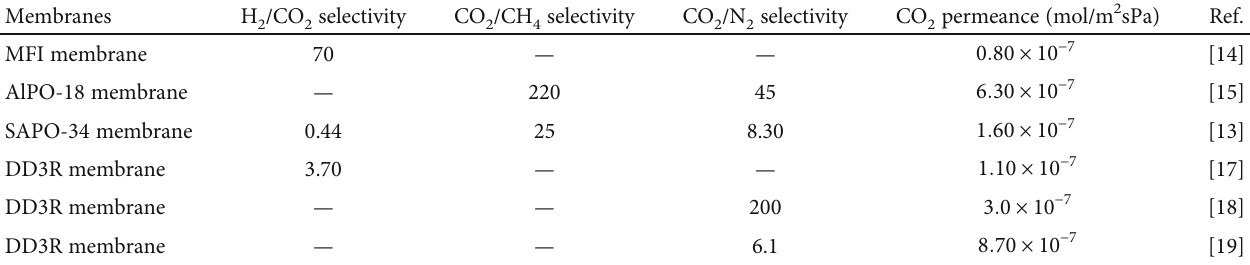
separation from CH 2 4